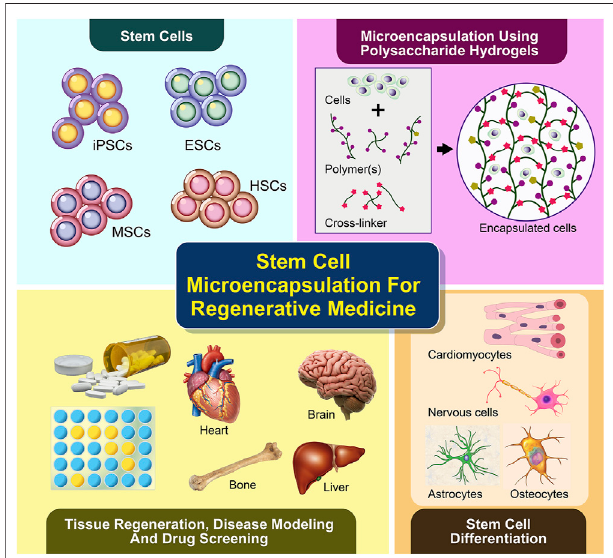
FIGURE 1 | Microencapsulation of stem cells using polysaccharide- based hydrogels supports cell differentiation and viability in 3D, which has been recently applied in tissue regeneration or cell therapy and disease modeling for future drug screening.